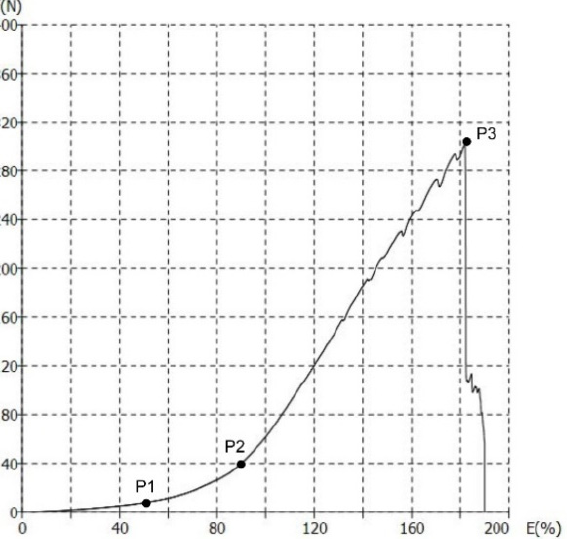
Figure 2. Identification of breakpoints in the regions of elastic, elastoplastic and plastic.